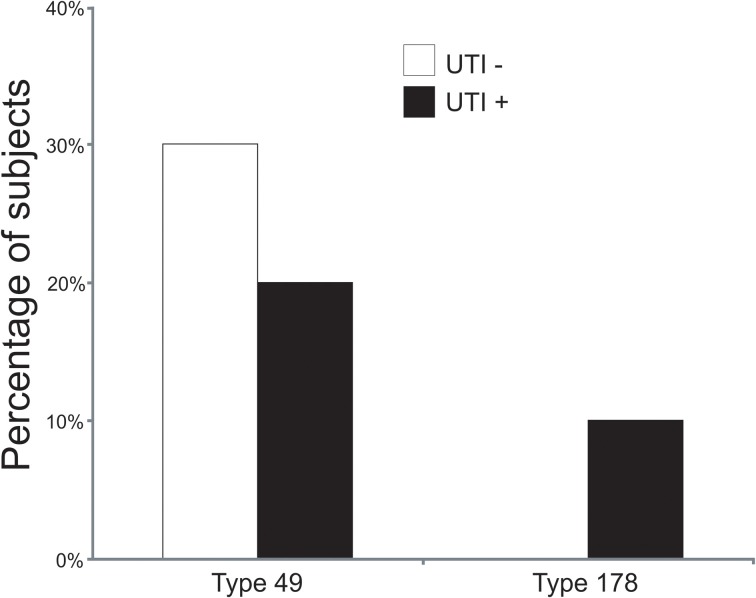
Bar graphs of the percentage of subjects with detectable HPV Types 49 and 178 by quantitative PCR. White bars indicate those subjects with negative urine cultures, and black bars represent subjects with urinary tract infections.